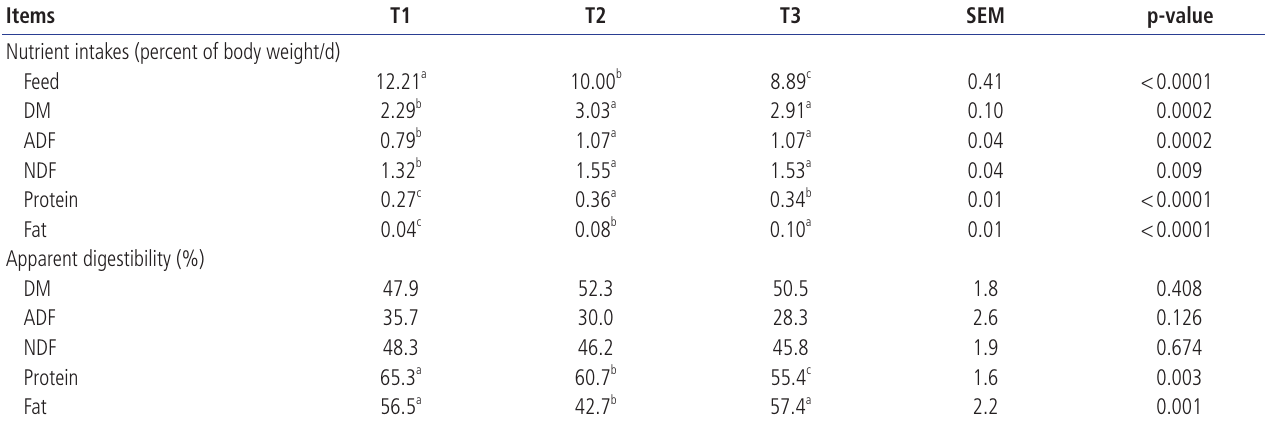
Table 3. The average nutrient intakes and apparent nutrient digestibility measured for 5 days at the end of each period in goats fed three different diets Items T1 Nutrient intakes (percent of body